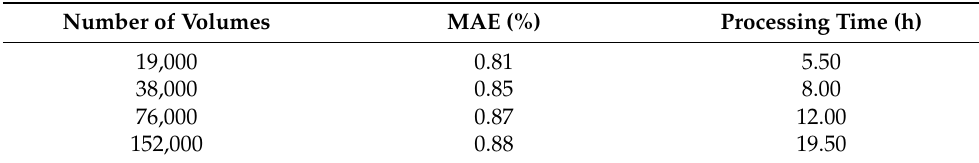
Table 5. Average MAE and simulation time values for each mesh.